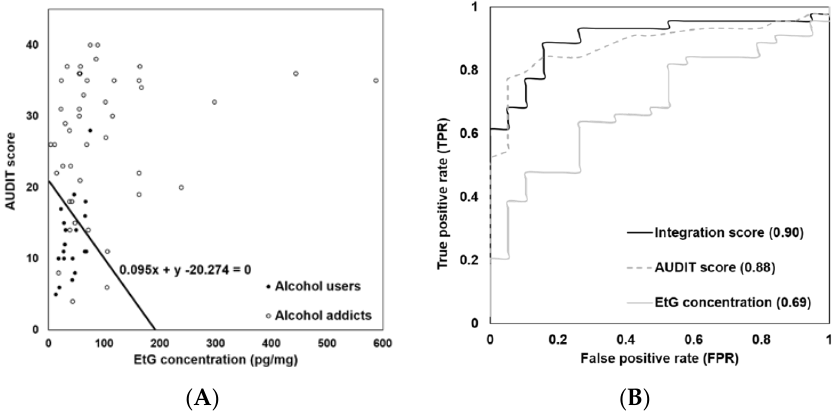
Figure 7. Performance evaluation of the hair EtG concentration, the AUDIT score and the integration score. ( A ) Scatter plot of the hair EtG concentrations and the AUDIT scores in alcohol addicts ( n = 44, closed circle) and average alcohol users ( n = 19, open circle). The optimal dividing line is presented as a black line with its equation. ( B ) ROC of the hair EtG concentration, the AUDIT score and the integration score. The AUC values are in parentheses.